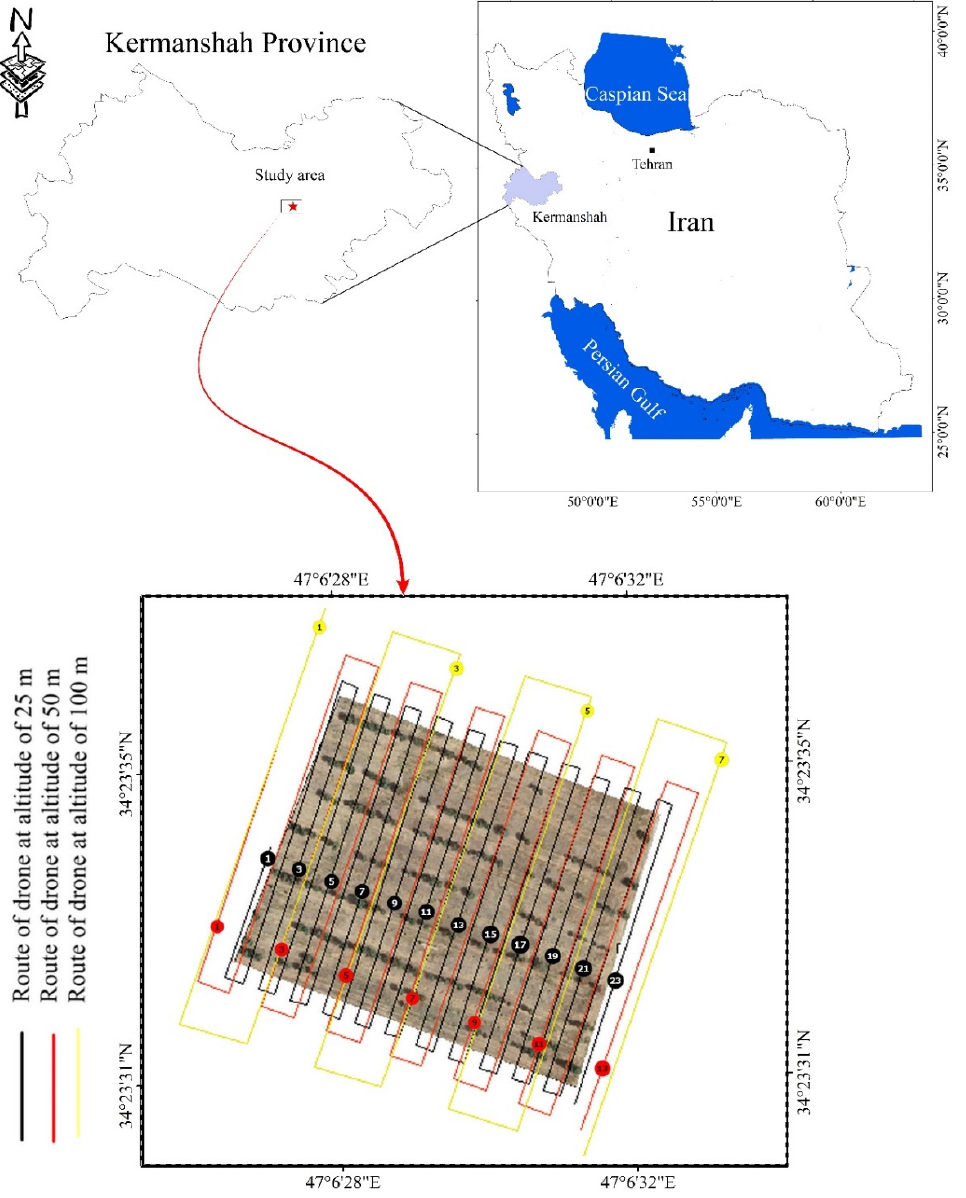
Figure 1. Location of the study area in Kermanshah province (western Iran) and photo of the study area with routes of drone at different altitudes of 25, 50, and 100 m.